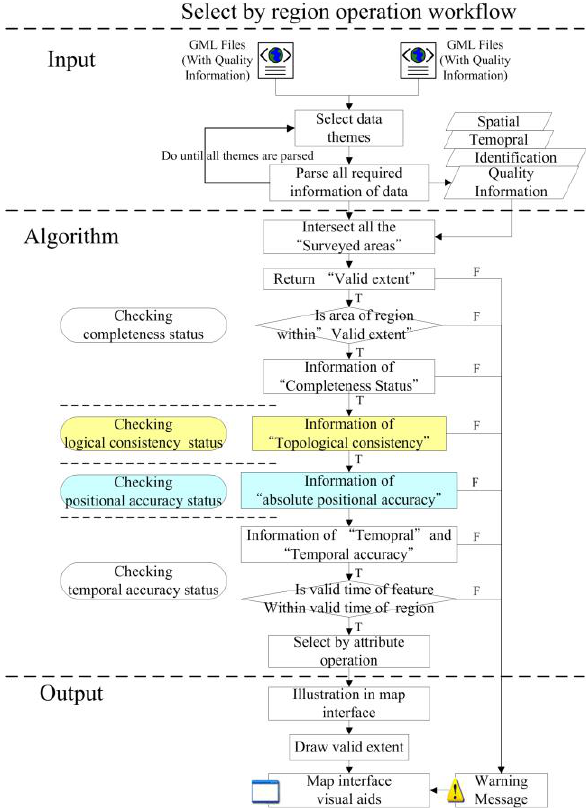
Figure 3. Workflow rule of select by region